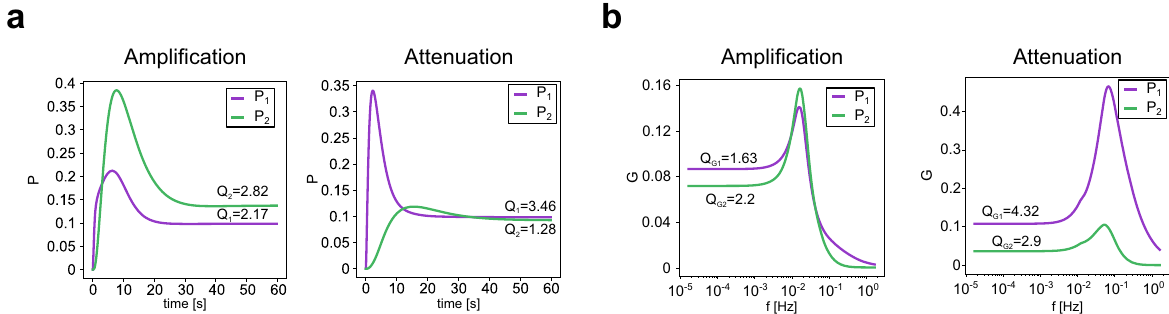
Fig. 9 Ampli fi cation and attenuation in cascades of CMCs. a Representative example of time courses exhibiting ampli fi cation (left) or attenuation (right) when stimulated with a step. b Representative examples of gain versus frequency plots exhibiting ampli fi cation (left) or attenuation (right) when periodically